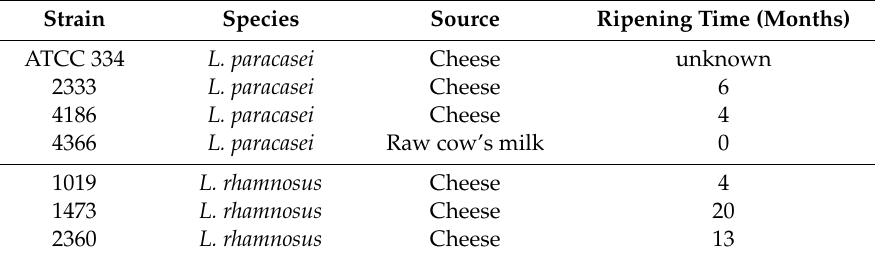
Table 1. Bacterial strains used in this study.